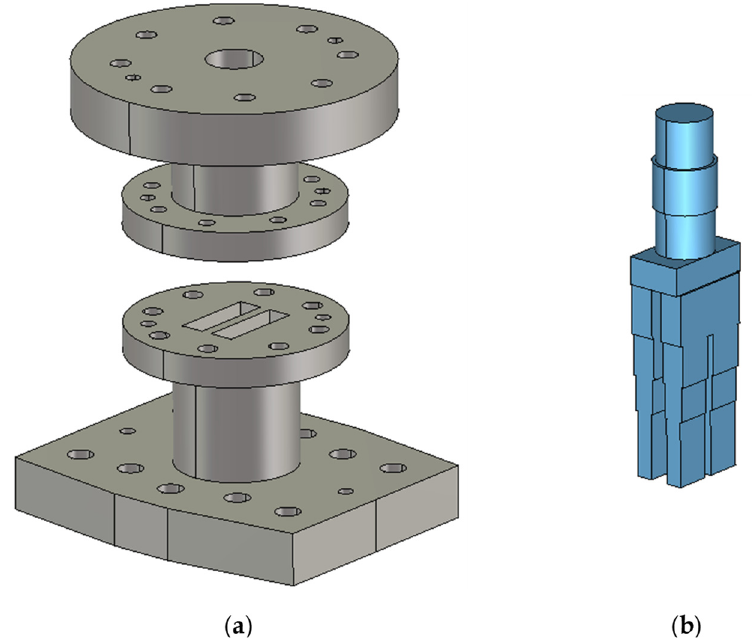
Figure 3. Representation of the mode converter: ( a ) the two waveguide parts that form the device, with the holes for screws and alignments pins visible; ( b ) depiction of the internal air cavities.